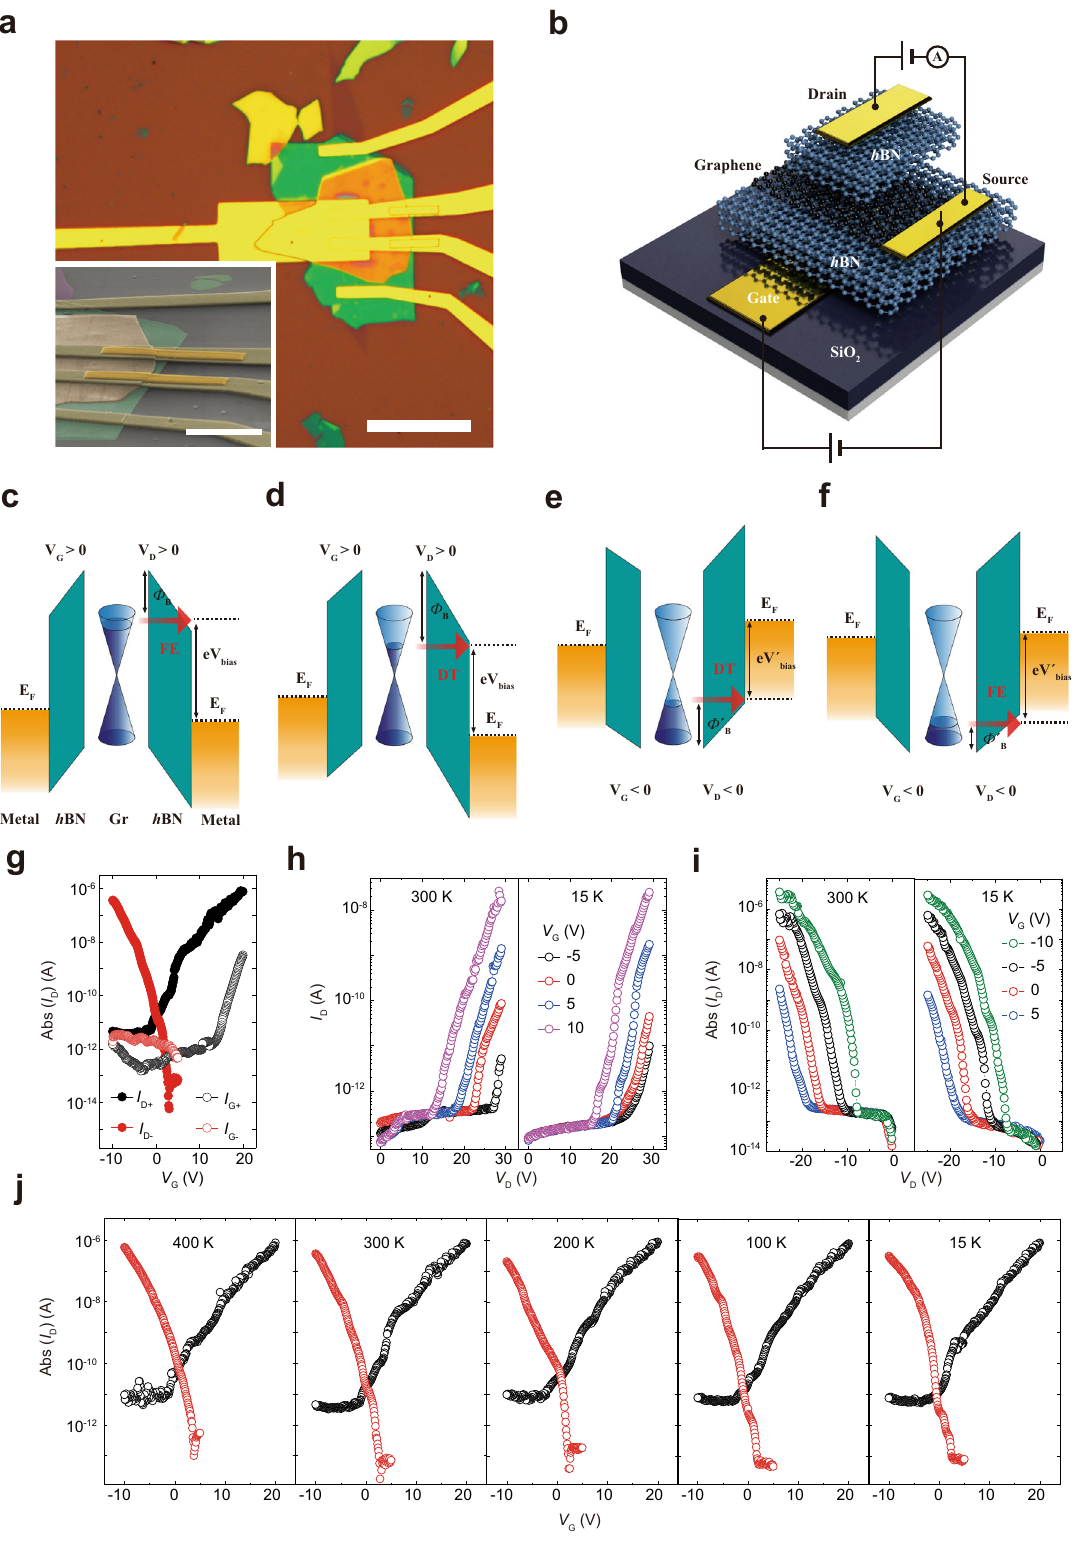
carriers of most semiconductors would be frozen 2 . The absence of degradation is a characteristic feature of our semiconductor-less ballistic device. The channel current in Fig. 1h, i shows two domains that re fl ect two different tunneling mechanisms (DT and FE) depending on the drain voltage ( V D ). First, ineffective